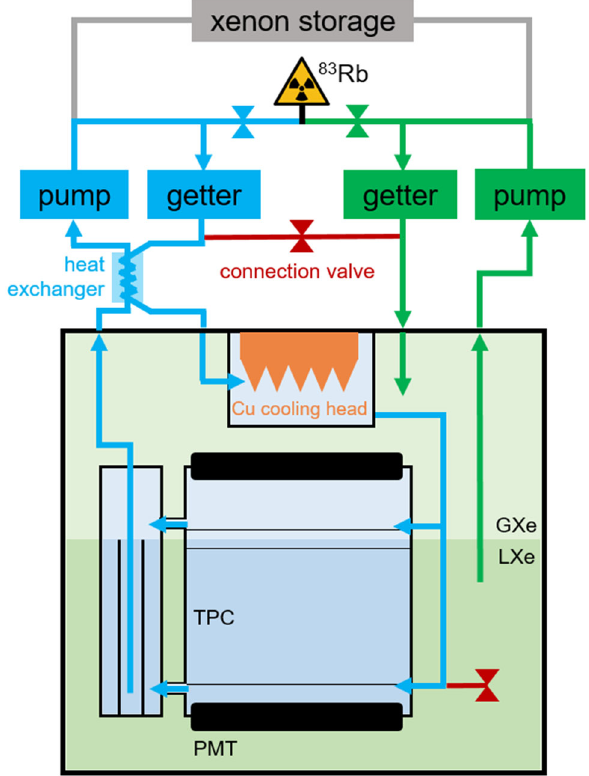
Fig. 2 Sketchofthexenonsupplyandpurificationsystems:Xenongas is supplied by a jointly used storage system (grey). Two independent gas systems purify the xenon contained in the inner (blue) and outer (green) volumes. The xenon is liquefied by a copper cooling head which isconnectedtothetargetvolume.Thevolumescanbeconnectedintheir liquid and gaseous phases by valves (red). The 83 Rb source installed between the two purification systems allows for detector